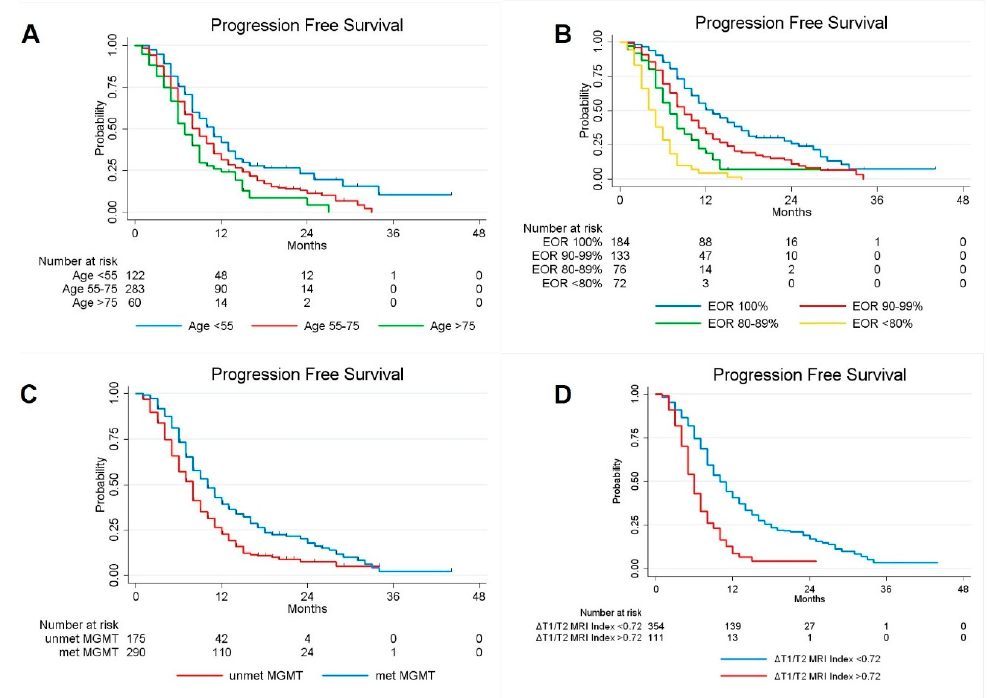
Figure 3. Kaplan-Meier curves displaying PFS of GBM patients according to Age ( A ); EOR ( B ): MGMT promoter methylation status ( C ); and preoperative Δ T1/T2 MRI Index ( D